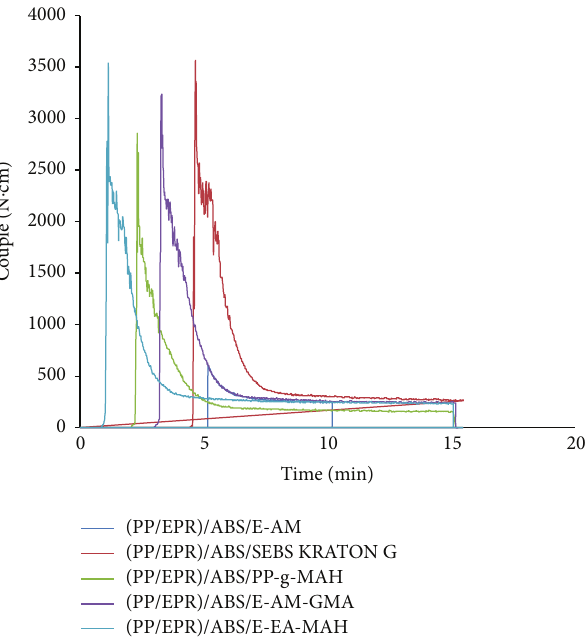
Figure 4: Variation of the torque exerted by the screws “rollers” internal mixer HAAKE PolyLab System on mixtures (PP/EPR)/ ABS/compatibilizers at rate of 5% of each one of the five compati-